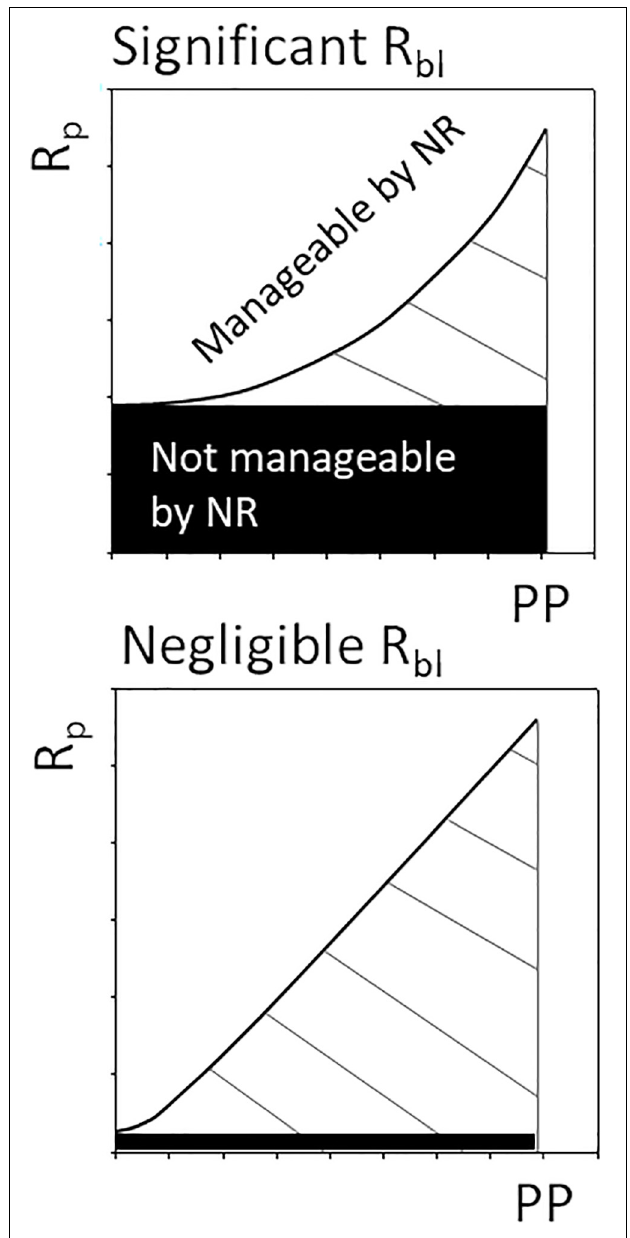
FIGURE 5 | Conceptual figure depicting management of plankton respiration (R p ) indirectly through nutrient reductions (NR) affecting the level of primary production (PP). In ecosystems with significant baseline respiration (R bl , e.g., with low productivity and high RTOC load), a limited share of oxygen consumption can be managed by nutrient reductions.